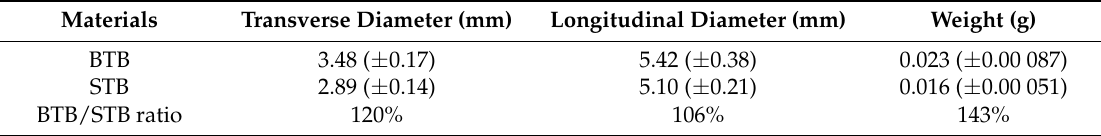
Figure 1. Fruit growth patterns of different accessions of Tartary buckwheat. ( A ) Pictures of mature fruits of the two accessions. ( B ) Average fresh weight of one fruit of the two Tartary buckwheat accessions (STB, black squares; BTB, red circles) is plotted against the developmental stages (days after pollination) ( n = 5). ( C ) Average longitudinal diameter of one fruit of the two Tartary buckwheat accessions (STB, black squares; BTB, red circles) is plotted against the developmental stages (days after pollination) ( n = 5). ( D ) Average transverse diameter of one fruit of the two Tartary buckwheat accessions (STB, black squares; BTB, red circles) is plotted against the developmental stages (days after pollination) ( n = 5); * and ** indicate significant differences ( α = 0.05; α = 0.01, least significant difference test (LSD)) among treatments, respectively. Table 1. Plant materials used in this study and their characteristic mature fruit size and